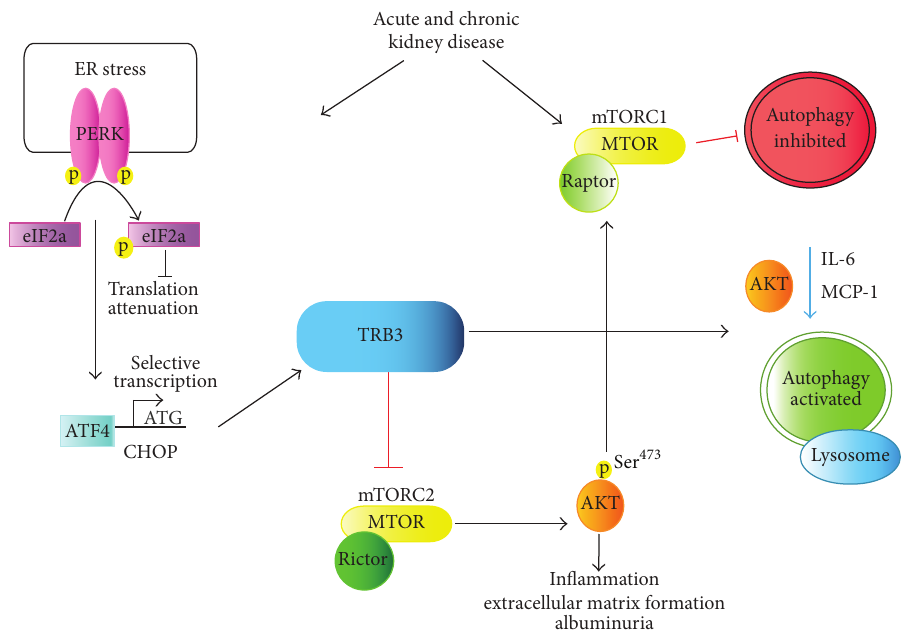
Figure 2: TRB3 at the crossroads of ER stress and mTORC function. Acute and chronic kidney disease are associated with activation of the Endoplasmic Reticulum Stress pathway. During ER stress Protein kinase RNA (PKR)-like ER kinase (PERK) phosphorylates eukaryotic translation initiation factor 𝛼 (eIF2 𝛼 ) and inhibits protein translation. Additionally, there is selective translation of activating transcription factor-4 (ATF4), which induces expression of C/EBP homologous protein (CHOP) and drives TRB3 expression. Kidney disease is also associated with activation of mTORC and inhibition of autophagy flux. We propose that in the kidney, TRB3 binds to Rictor and mTORC2 and inhibits phosphorylation of pAKT Ser 473 . This in turn reduces inflammatory gene expression (IL-6 and MCP-1) and potentially modifies activation of mTORC1 and